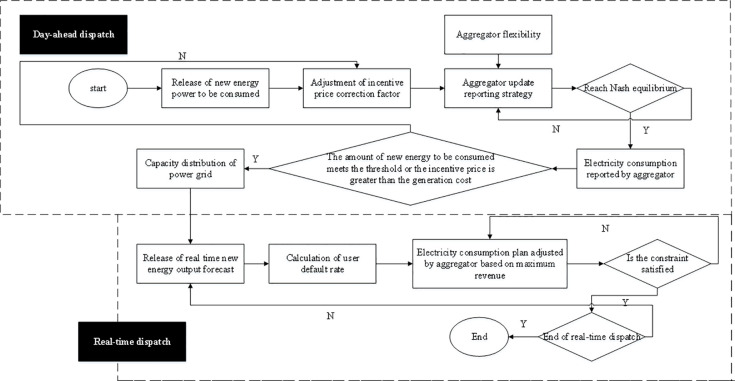
Implementation process of information economic dispatch in multi-periods.